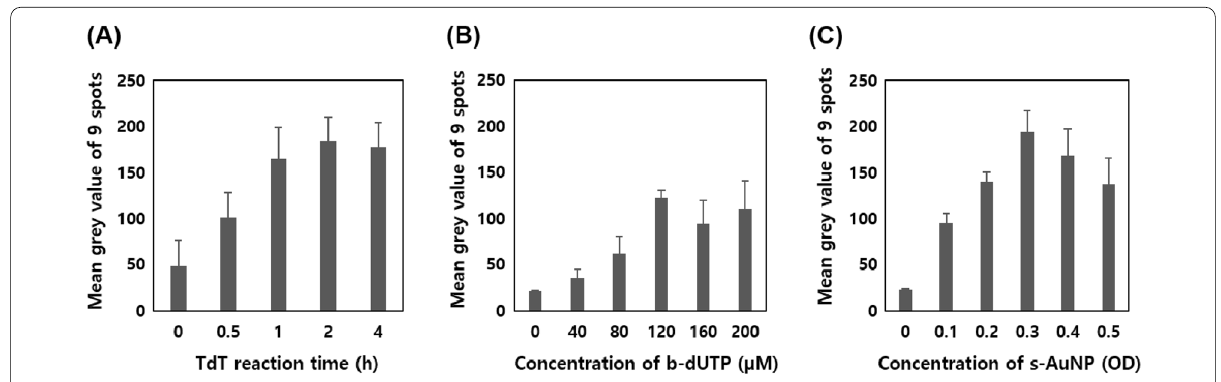
Fig. 3 Optimization results for TdT and s‑AuNP hybridization